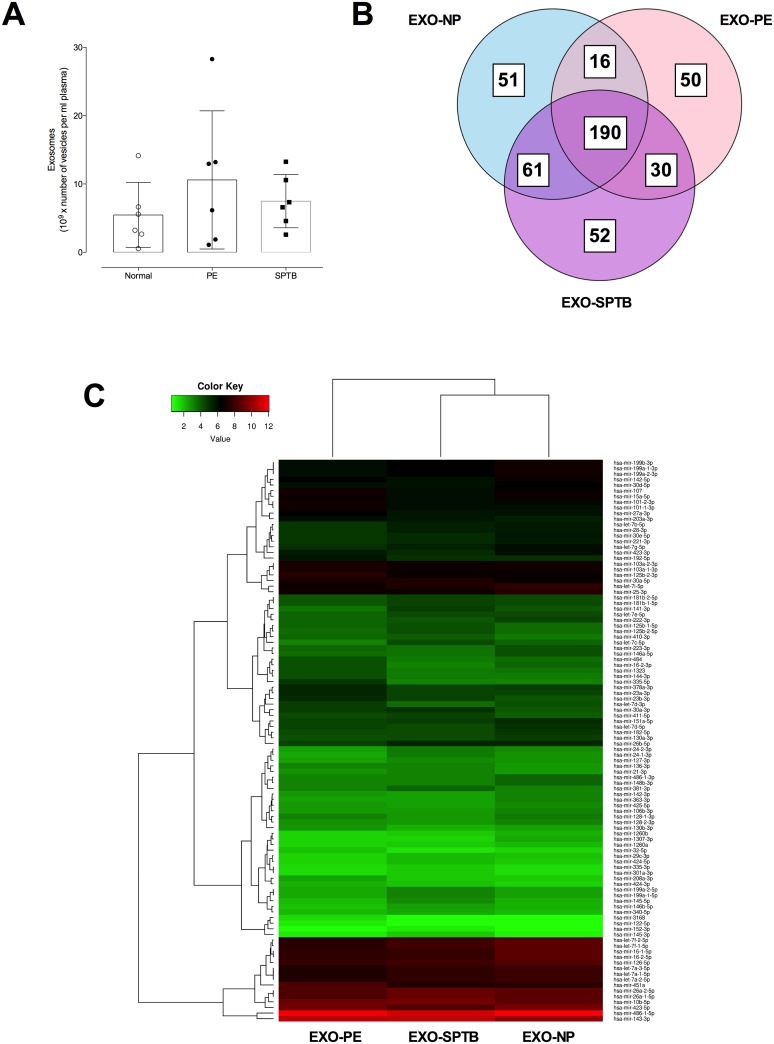
miRNA profile in exosome present in maternal circulation at early gestation.(A) number of exosomes in normal, preeclampsia (PE) and spontaneous preterm birth (SPTB) at early gestation. (B) The Venn diagram shows the distribution of common and unique miRNA identified in exosomes present in maternal circulation in normal (EXO-NP), PE (EXO-PE) and SPTB (EXO-SPTB). (C) Top 100 abundant miRNAs classified by normalised counts (see Methods) identified in exosomes isolated from maternal circulation. Hierarchical clustering of deep sequencing data was performed across exosomal miRNA samples. Normalisation of the reads was performed by DESeq2 using factors derived from the media ratio method.